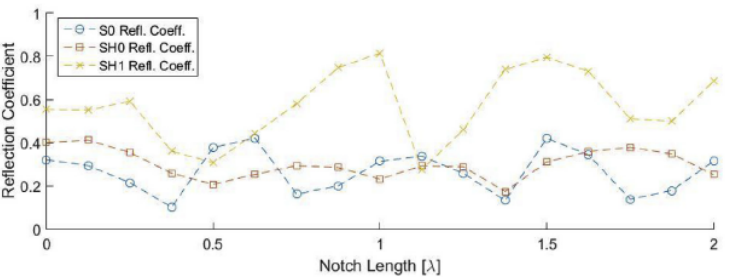
Figure 8. The predicted reflection coefficients of the S0, SH0 and SH1 modes at varying notch lengths and a fixed 30% notch depth on a 10 mm thick pipeline, using the 2D finite element method. Reprinted under Creative Commons CC BY license